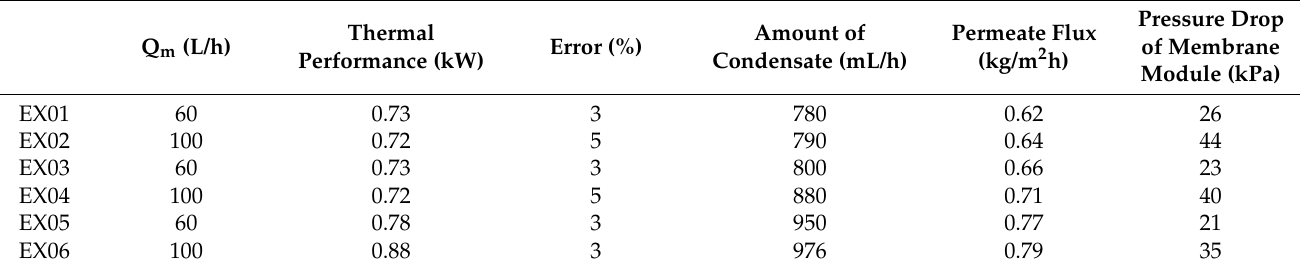
Table 3. Thermal performance, measurement error, condensate amount, permeate flux, and membrane module pressure drop for MM001.